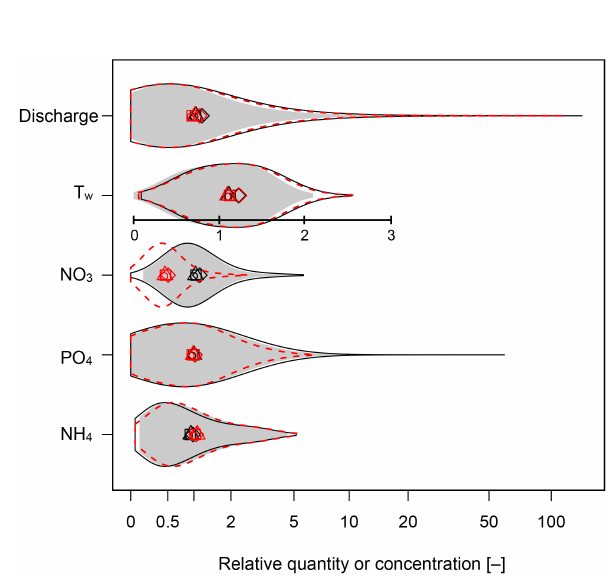
Figure 5. Ensemble future predictions for physical parameters and selected nutrients under management alternatives “all” (red) and “CurrPrac” (black), compared to present (grey). Distributions were normalized to be comparable across variables. Scale is logarith- mic, except for water temperature, where the locally placed linear axis applies. Open symbols indicate mean concentrations of indi- vidual scenarios: circle: “status quo”; square: “moderate growth”; diamond: “exploding growth”; pyramid: